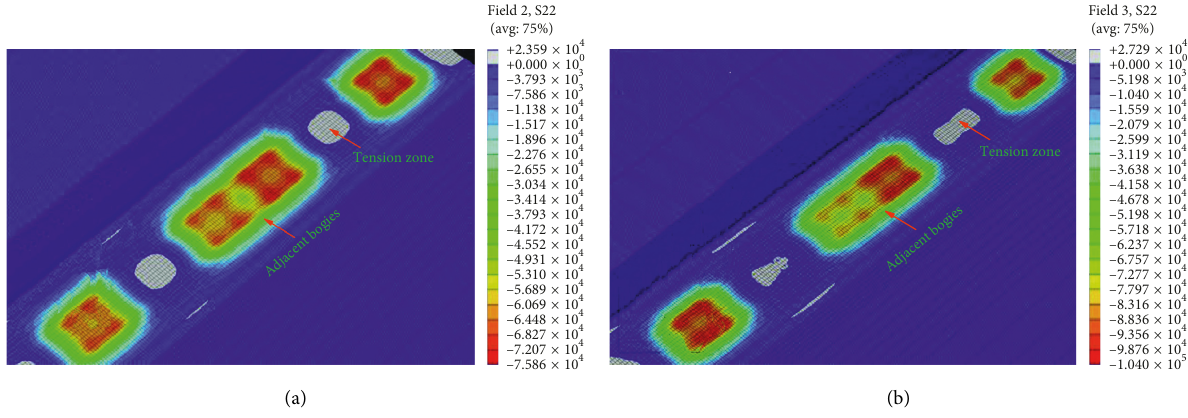
Figure 9: Dynamic stress contour at the subgrade surface: (a) smooth track; (b) vertically irregular track.